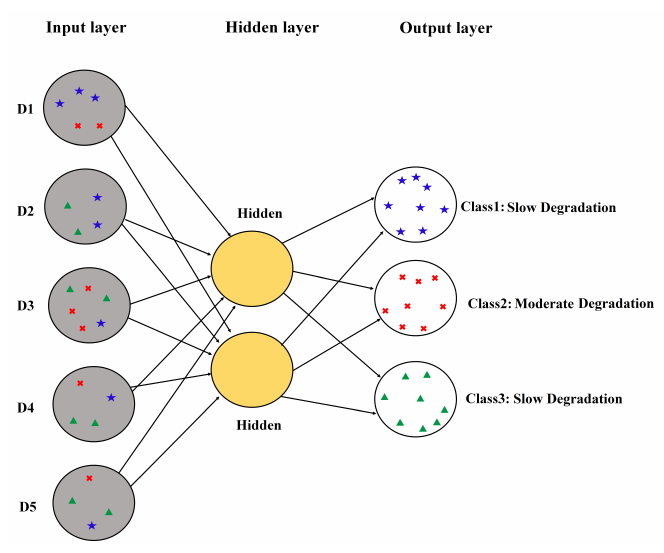
Figure 8. Neural network (NN)